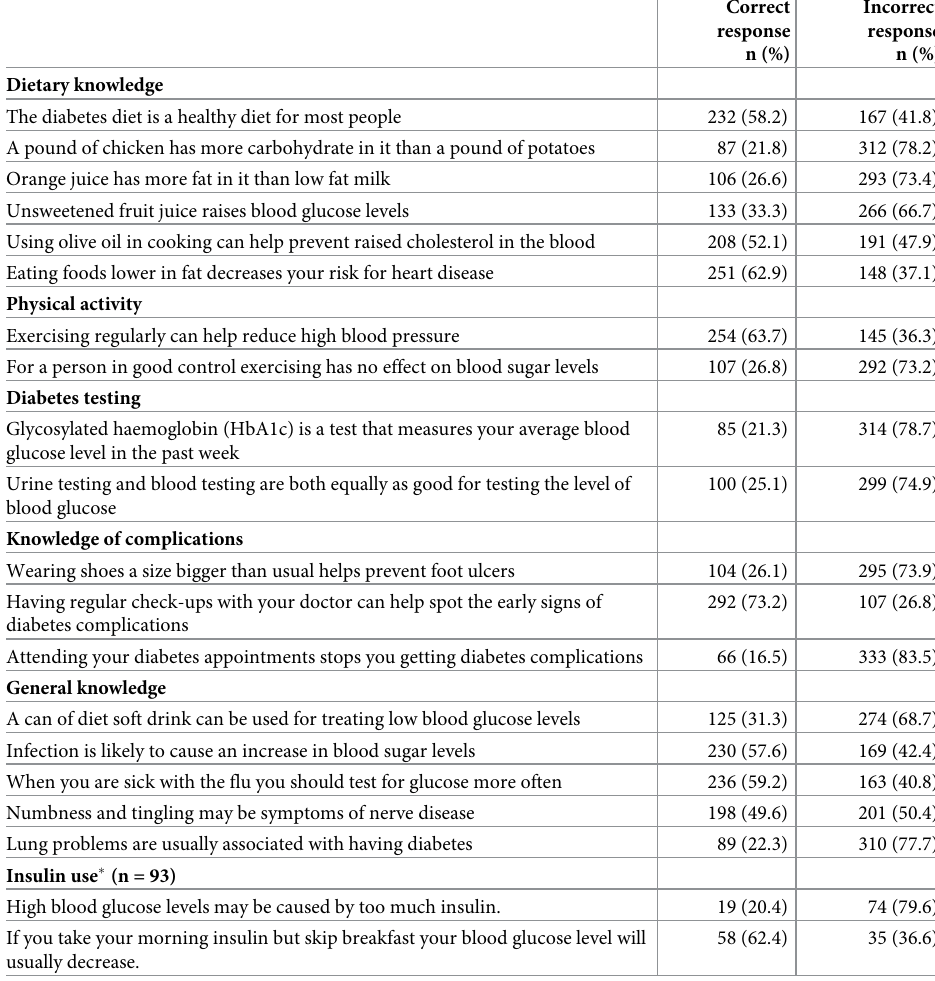
Table 2. Descriptive summary of participants’ diabetes